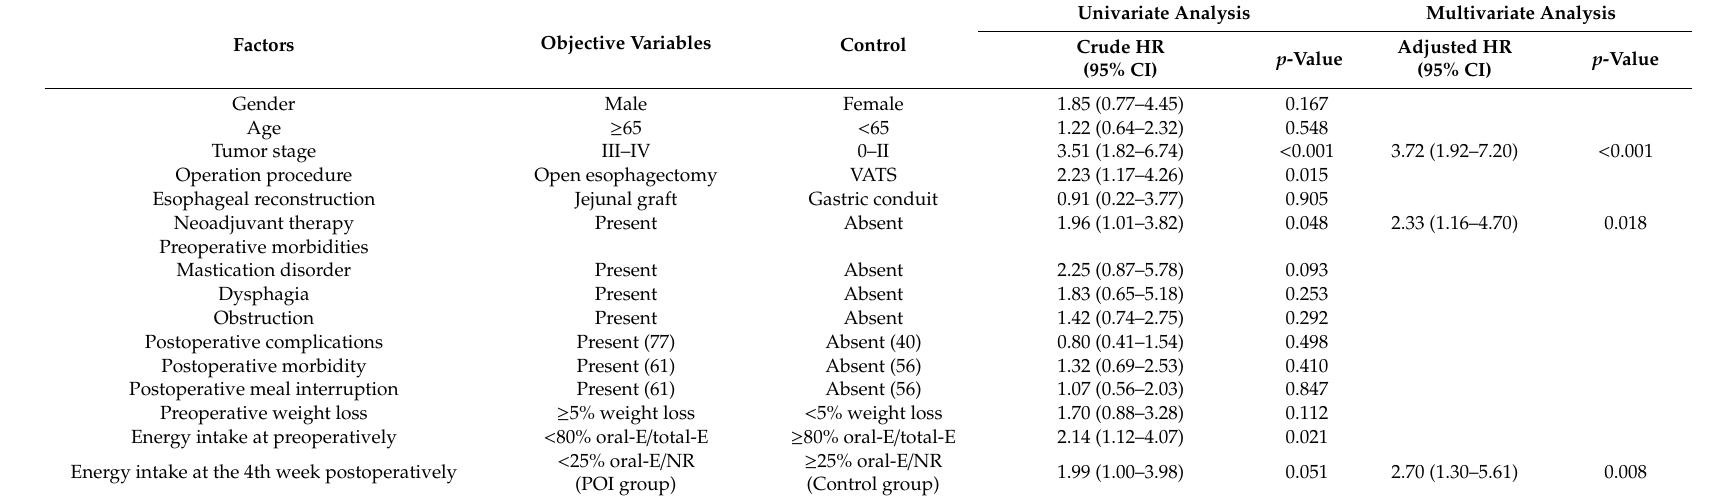
Table 3. Univariate and multivariate Cox regression analyses of prognostic factors in patients with esophageal